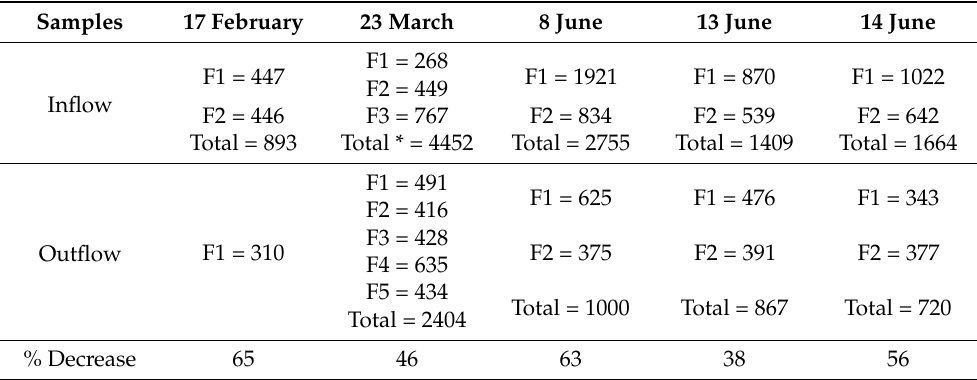
Table 1. MFs quantification in the inflow and outflow samples pretreated and vacuum filtered.